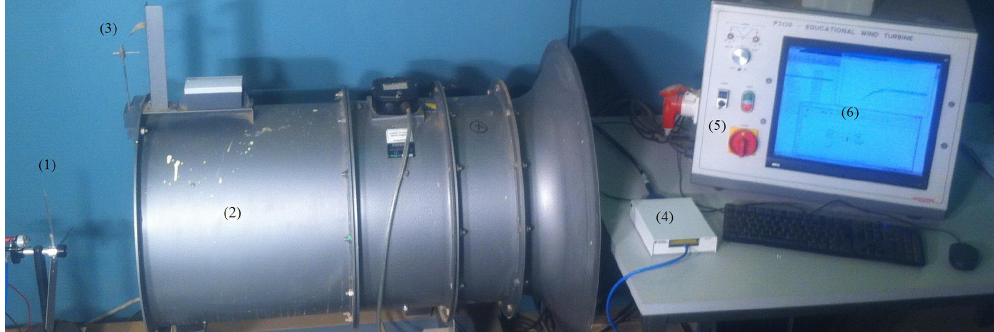
Figure 6. Test-rig: (1) wind turbine, (2) wind generator, (3) Pitot tube, (4) Data acquisition, (5) wind speed controller, (6) datalogging display.